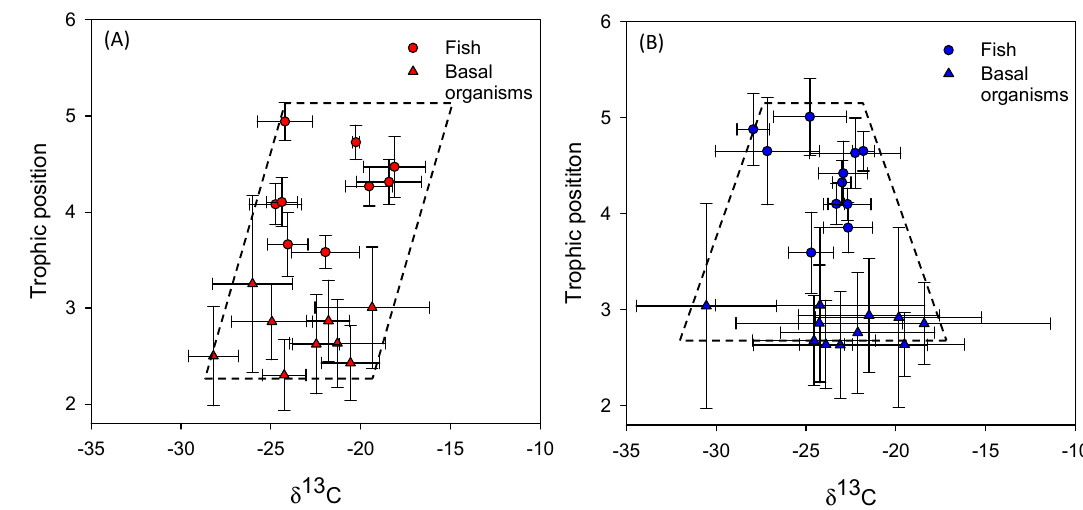
Figure 7. General trophic structure of the fish community (circles) and basal organisms (triangles) in lakes in the Azores